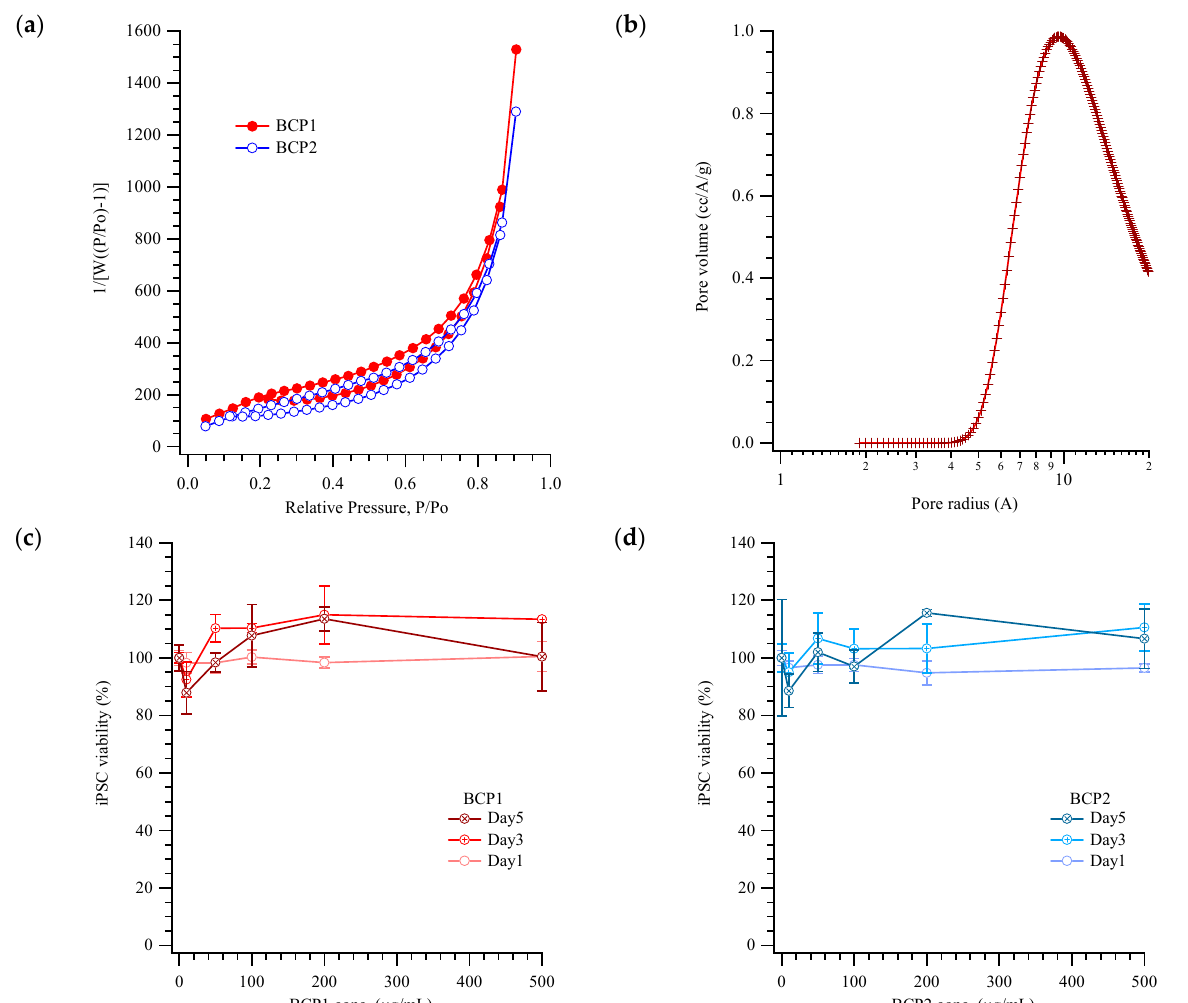
Figure 2. ( a ) The nitrogen adsorption and desorption on BCP1 and BCP2 porous granules; ( b ) pore size distribution of BCP1 and BCP2 fitted by the Barrett–Joyner–Halenda (BJH) model. Viability of iPSCs with various concentrations of ( c ) BCP1 and ( d ) BCP2 on the 1st, 3rd, and 5th day, normalized to unexposed control cells.